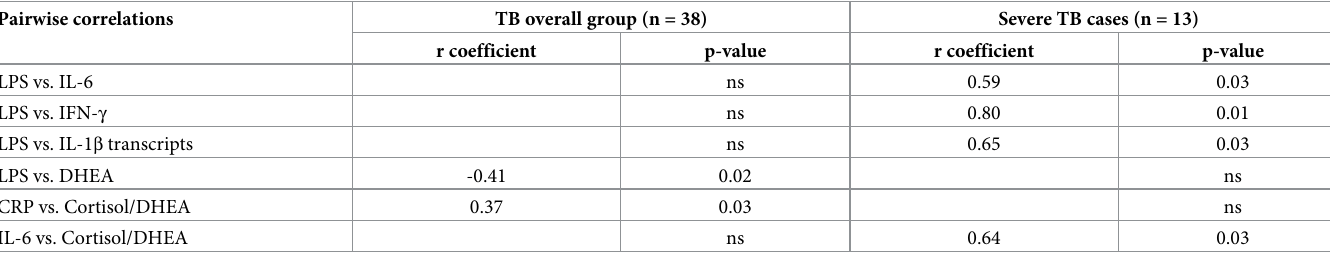
Table 6. Correlation analysis of hormone, cytokine and LPS plasma levels in the overall group of TB patients and those with severe disease. Pairwise correlations TB overall group (n =